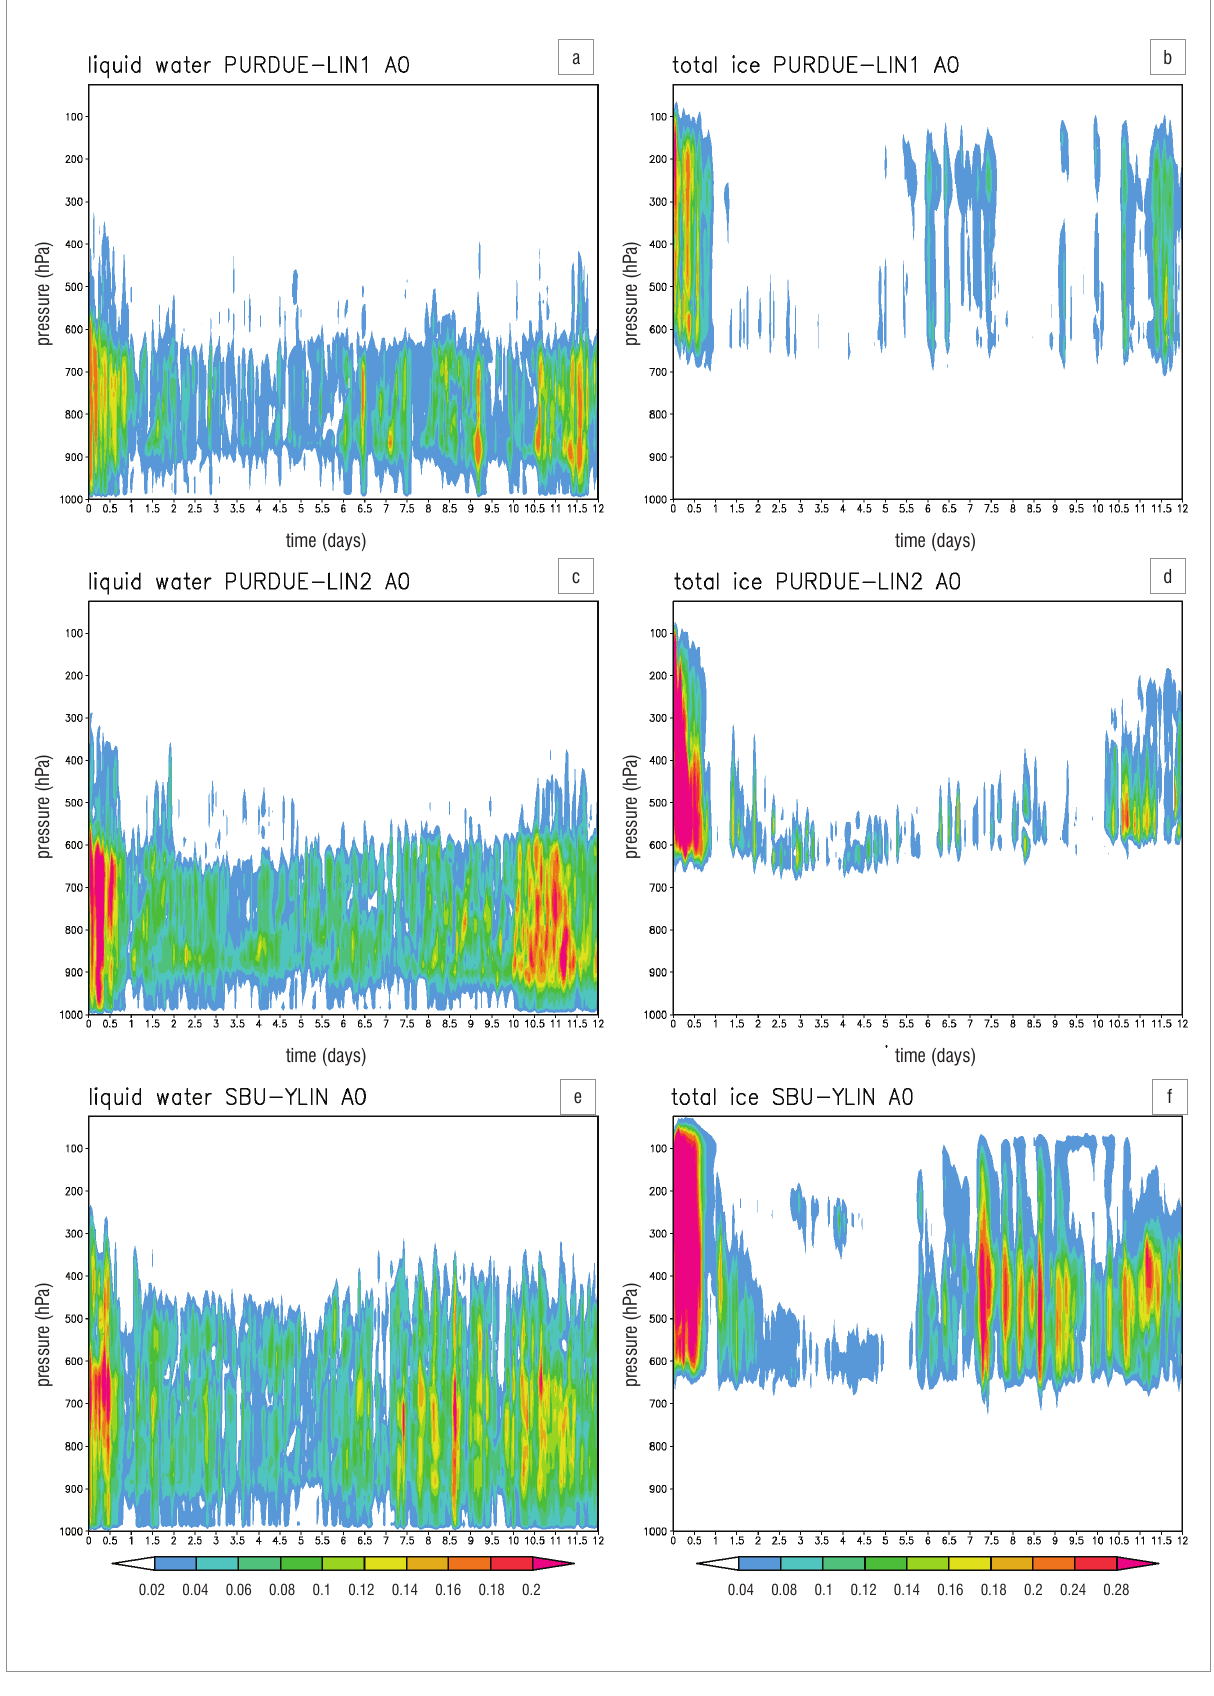
Figure 5: The temporal evolution of the simulated (a,c,e) liquid and (b,d,f) ice mixing ratios by the different microphysics schemes for the A0